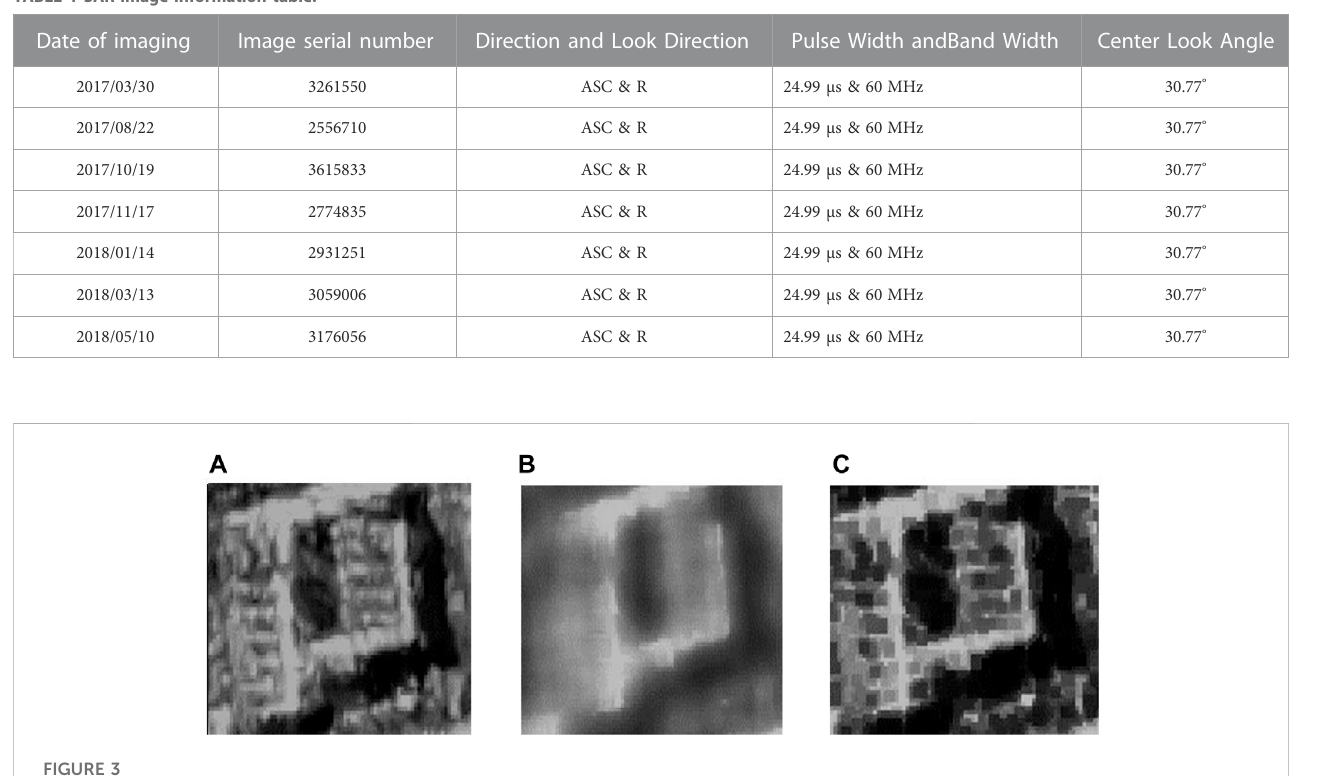
TABLE 1 SAR image information table.